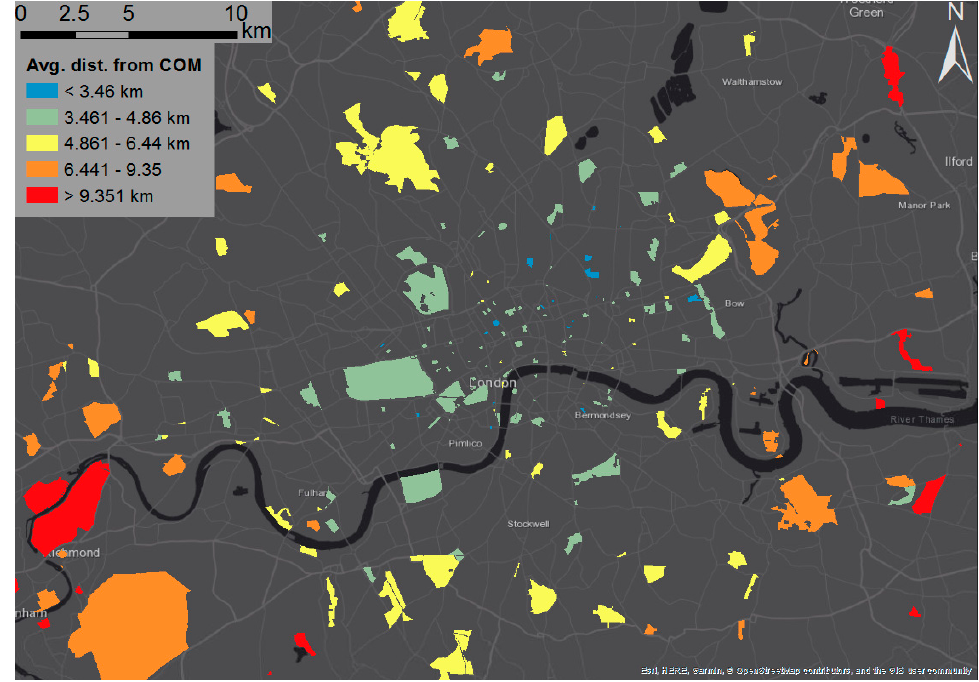
Figure 8. Average distance from users’ COM to the park, aggregated on park level based on the tweets posted from a given park.